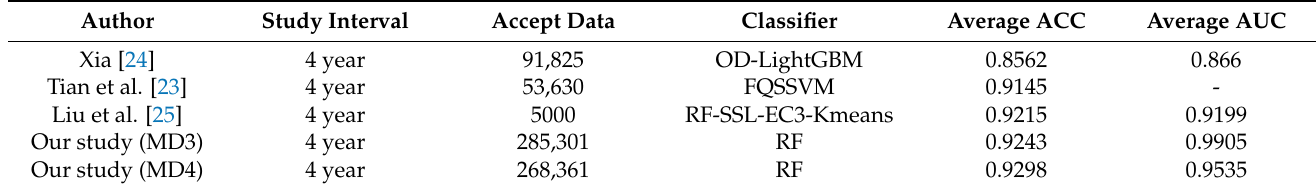
Table 10. A consolidated comparison of this study and previous